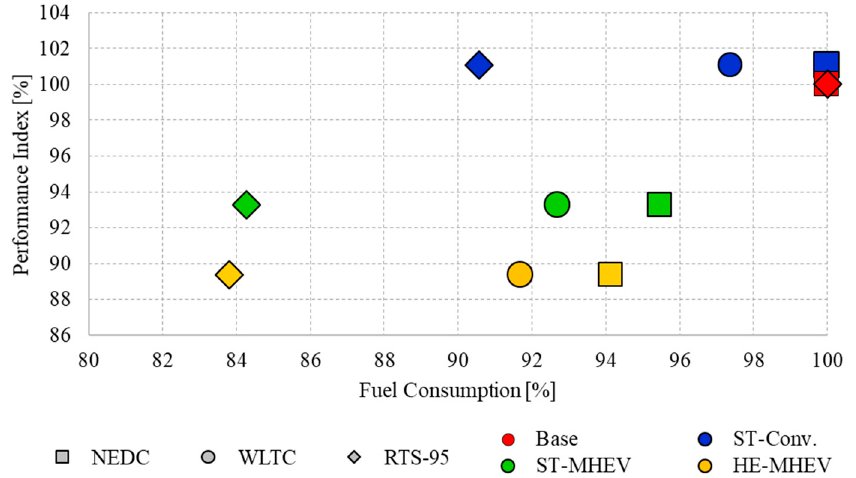
Figure 14. Performance Summary: Normalized Performance Index vs Normalized Fuel Consumption evaluated on NEDC, WLTC and RTS-95.